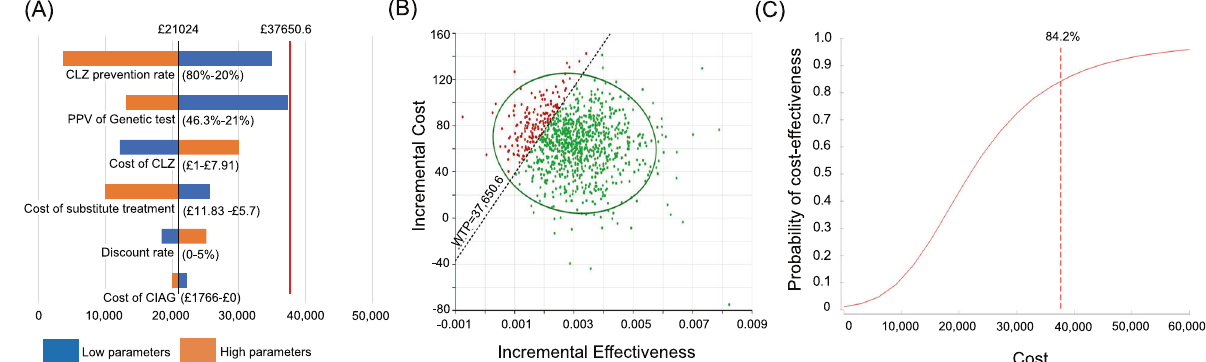
Fig. 2 Base – case scenario analysis in Japan. A Tornado plot of the one-way sensitivity analysis: The black vertical line indicates the incremental cost-effectiveness ratio (ICER) of the base-case analysis. The red vertical line indicates the cost-per QALY threshold. The numbers are the ranges used in the sensitivity analysis. The blue shaded bars represent lower parameters than those used in the base – case analysis, and the red shaded bars represent higher parameters than those used in the base-case analysis. B Scatter plot for incremental cost and effectiveness: green dots indicate ICERs within willing to pay threshold and red dots indicate out of the threshold. C Cost-effectiveness acceptability curve, CLZ clozapine, PPV positive predictive value, CIAG clozapine-induced agranulocytosis/granulocytopenia, WTP willing to